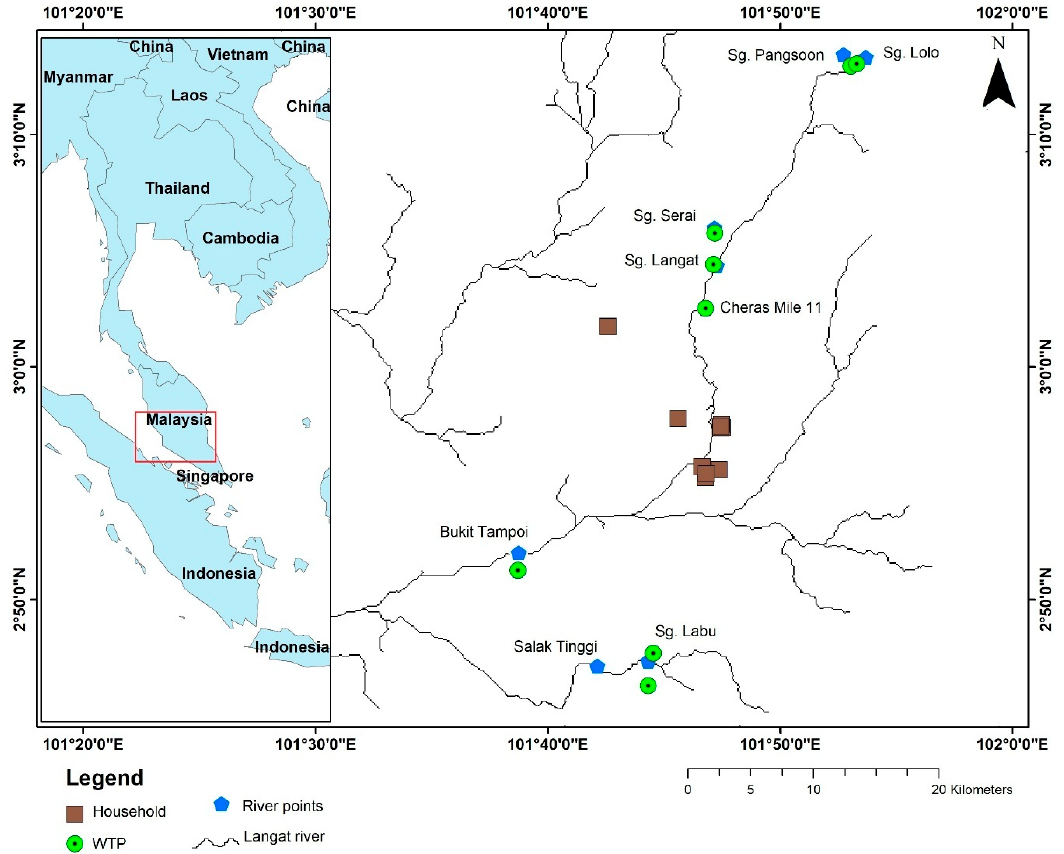
Figure 1. Water sampling points at Langat River Basin, Malaysia.